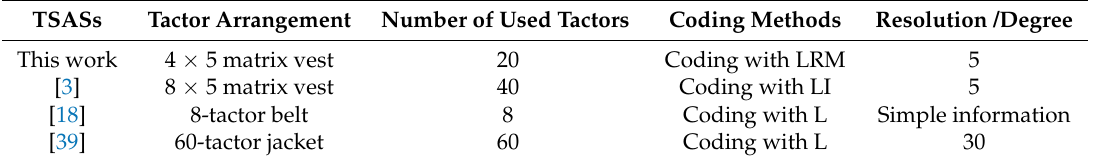
Table 6. Performance comparison between our work and previous